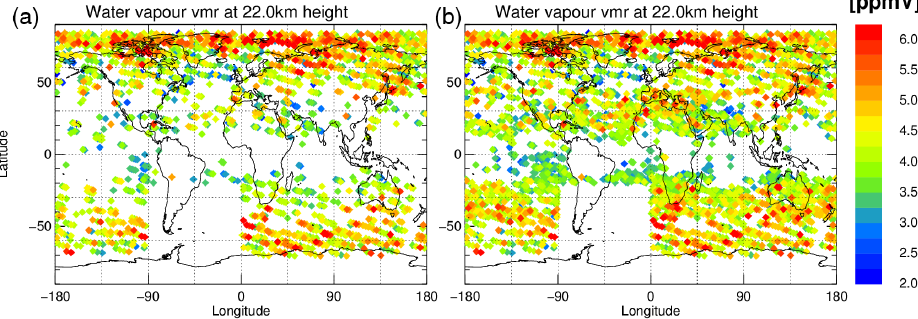
Figure 7. Coverage of the water vapour retrieval from SCIAMACHY limb measurements for April 2004. The position of each profile is indicated; the colour scale shows the volume mixing ratio of water vapour at 22km height. Data are shown for (a) every eighth day globally (1, 9, 17, 25 April) and (b) every eighth day globally and every second day between 45 ◦ S and 45 ◦